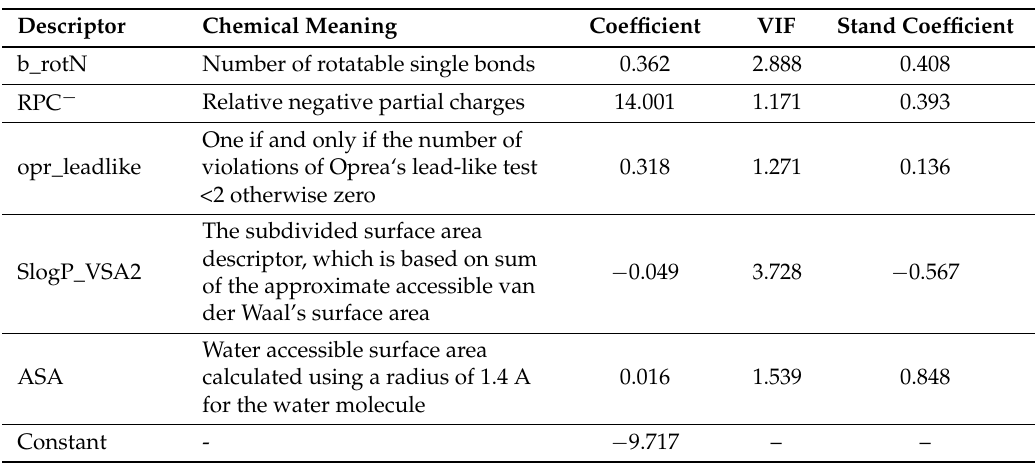
Tabl e 2. The correlation matrix of descriptors.